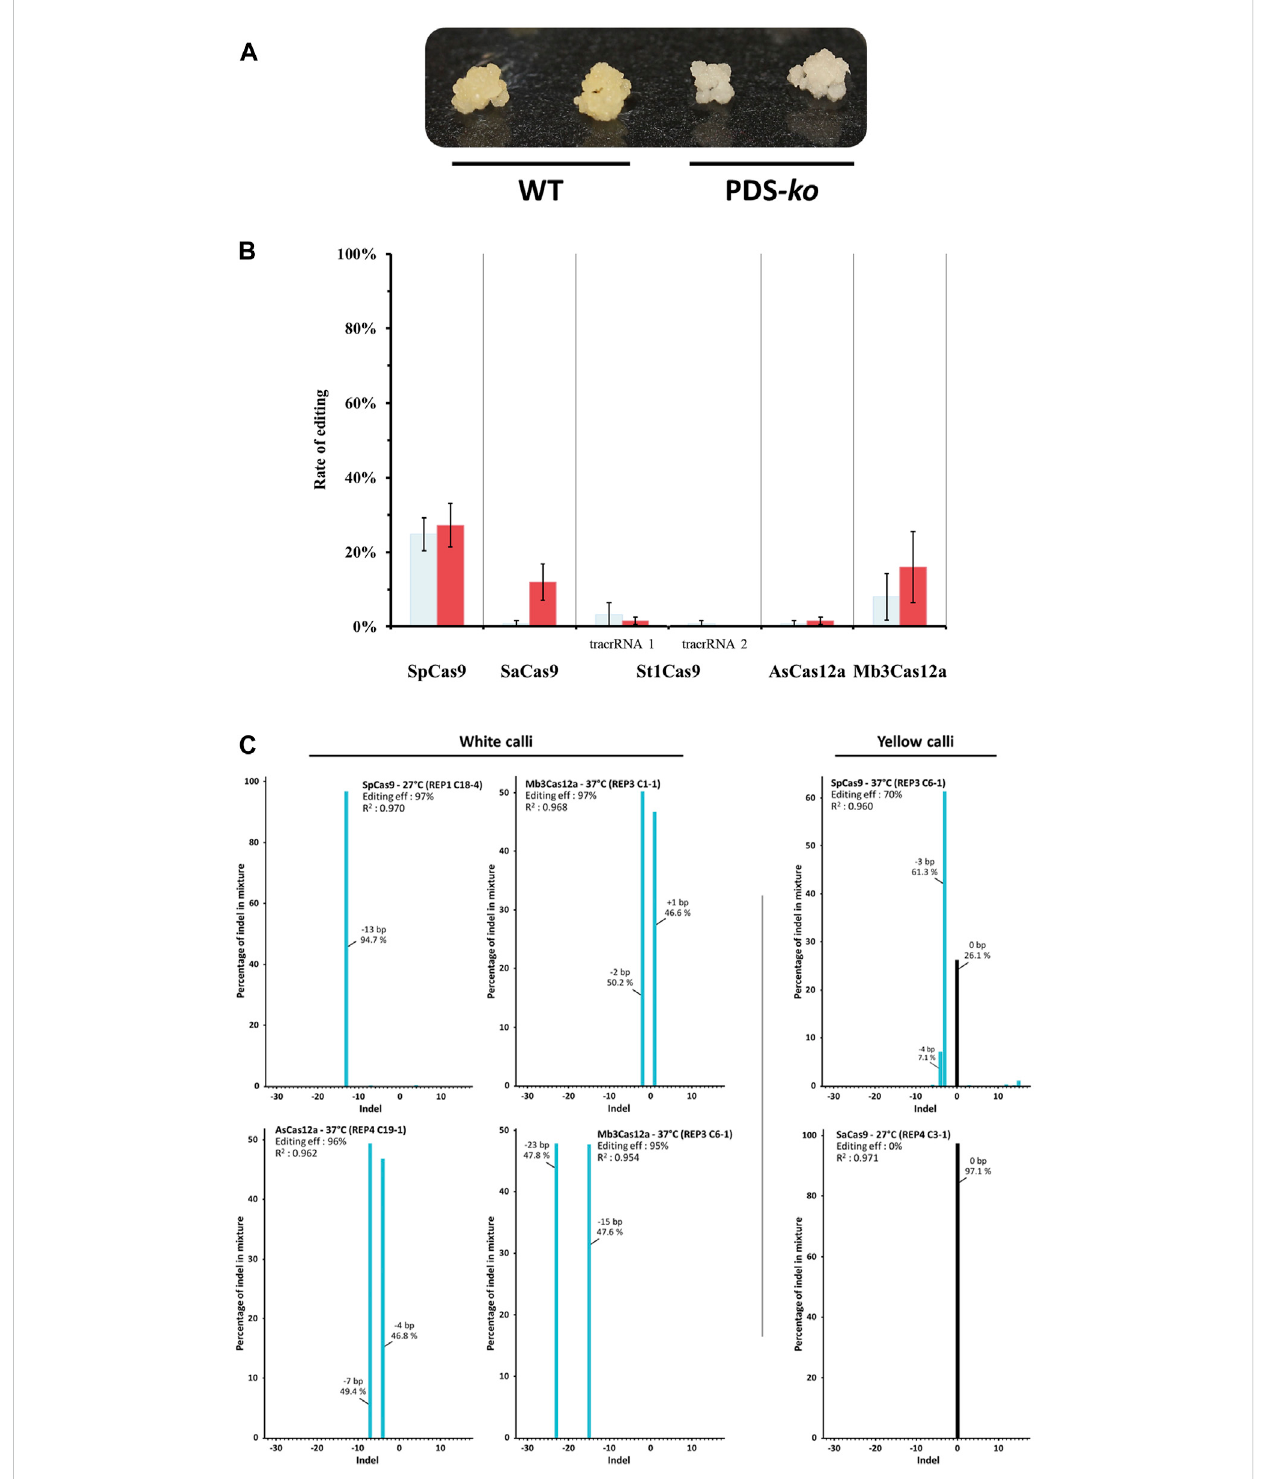
FIGURE 2 Gene editing using different Cas9/Cas12a variants. (A) Representative rice embryogenic callus phenotypes. Wild-type (WT) calli are yellow, while PDS- ko calli are white. (B) CRISPR-Cas gene editing ef fi ciency of rice phytoene desaturase (OsPDS) gene both at 27 ° C (light blue) and 37 ° C (red). Bar graphs show the percentage of PDS mutants identi fi ed by transformed calli visual inspection. Standard error mean (SEM) is indicated by whiskers. St1Cas9trans-activatingCRISPRRNA(tracrRNA)reportedbyEsveltetal.(2013)(tacrRNA1)andBrineretal.(2014)(tacrRNA2),respectively. (C) Indel distribution of insertions and deletions from single samples analyzed by Sanger